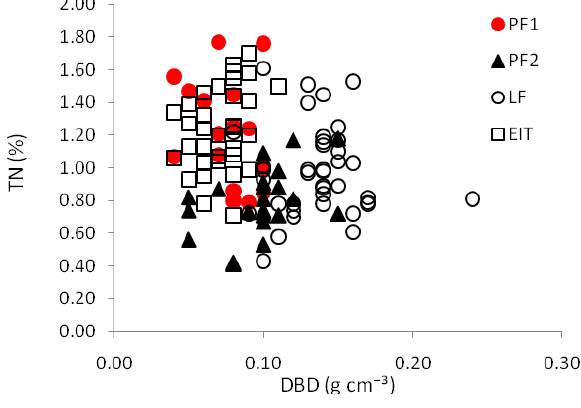
Fig. 3. A scatter plot TN versus TOC according to Drainage Groups.